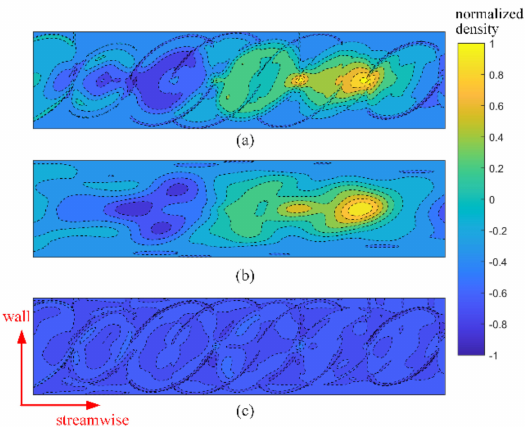
Figure 15. The transient density field and the reconstructed density field with proper orthogonal decomposition (POD) modes (density field is normalized to [ − 1, 1] by the minimum and maximum value): ( a ) Transient density field; ( b ) reconstructed density field with 10 POD modes (96.7%); ( c ) residual density field.